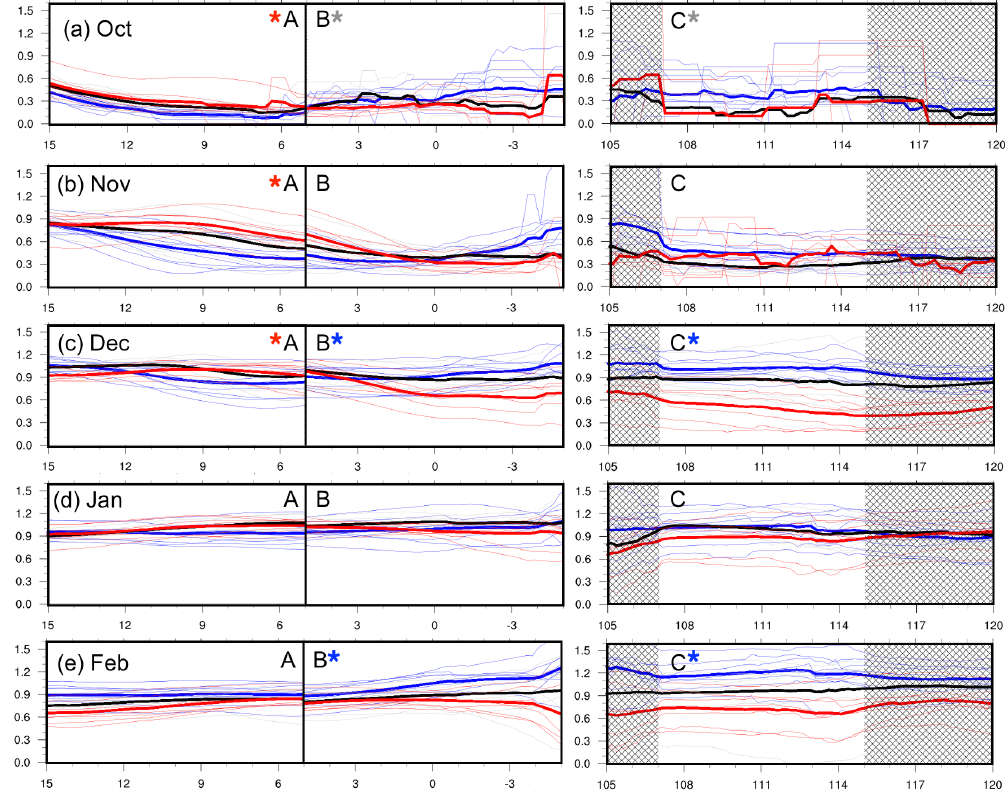
Figure 7. Like Fig. 6 but for the “frac” component, which reflects monsoon wind